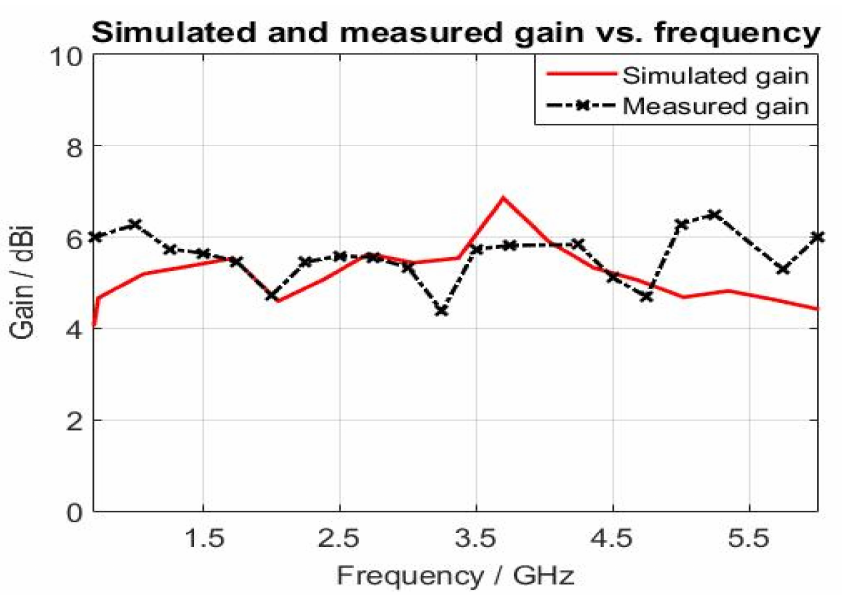
Figure 18. Presentation of the simulated and measured realized gain in dBi versus frequency.